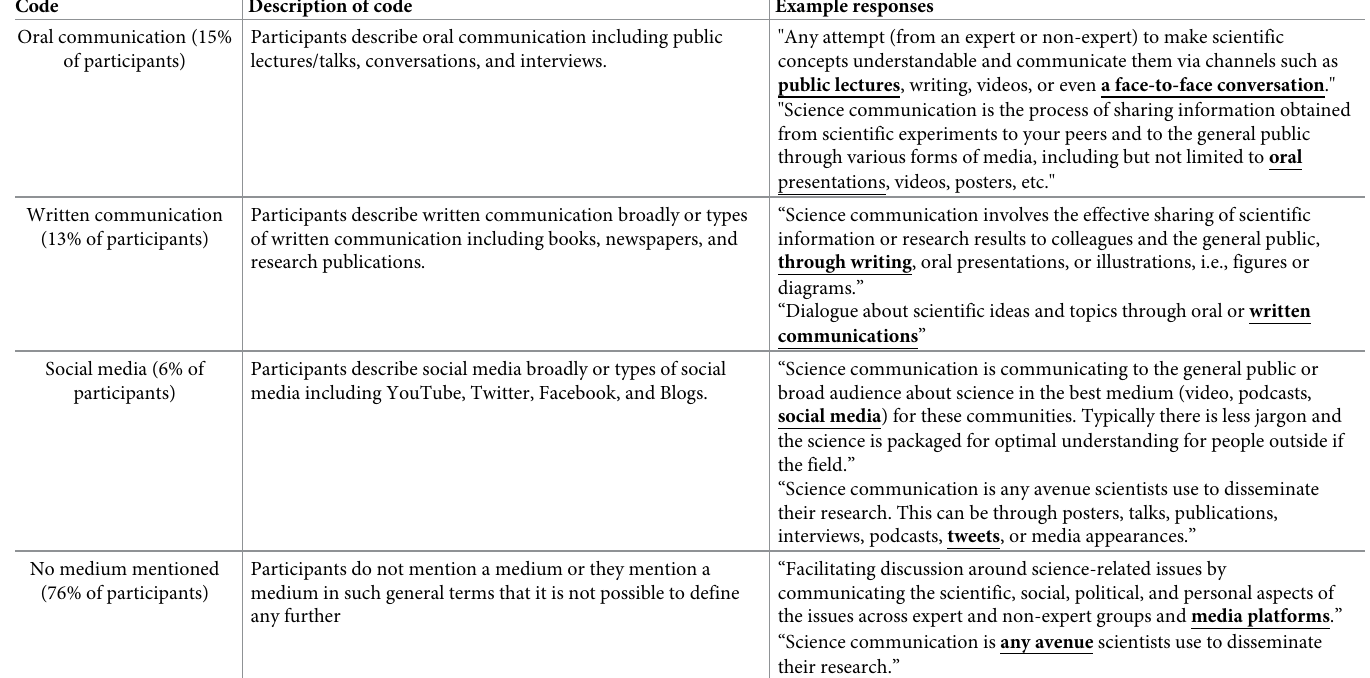
Table 3. Mediums through which STEM graduate students envision science communication. As described in the methods section, responses corresponding to more than one code were coded to each code they correspond with within the same